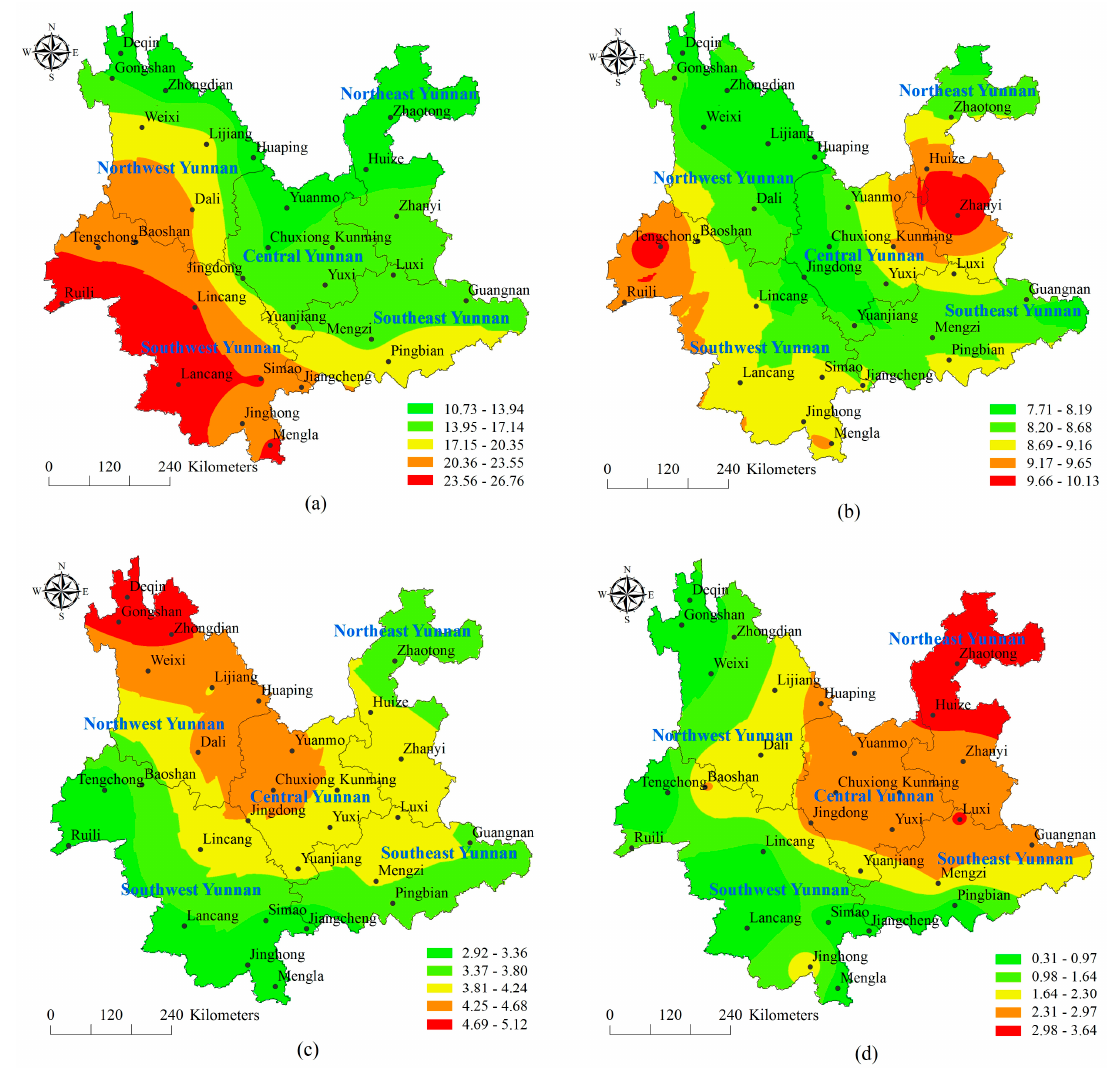
Figure 3. Occurrence frequency distribution of drought event based on different grade in Yunnan from 1960 to 2015 ( a ) slight drought; ( b ) moderate drought; ( c ) severe drought; ( d ) extreme drought.